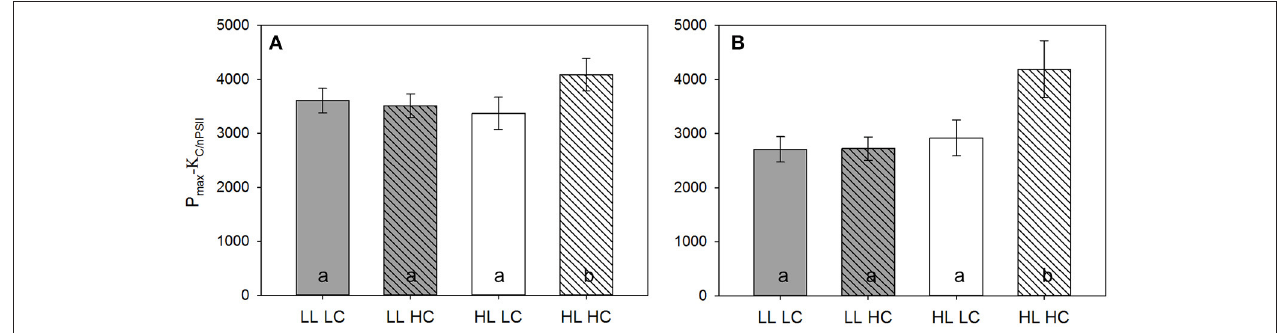
FIGURE 6 | Conversion factor between maximum electron transport rates and carbon fixation, P max -K C /n PSII , as described in more detail in Schuback et al. (2016), measured in LL (gray bars) and HL incubators (white bars) under LC (open bars), and HC (hatched bars) over 24 h directly before the dilution (A) and the final sampling (B) of the experiment ( n = 3, errors bars indicate 1 s.d.). Different letters indicate significant differences between treatment.